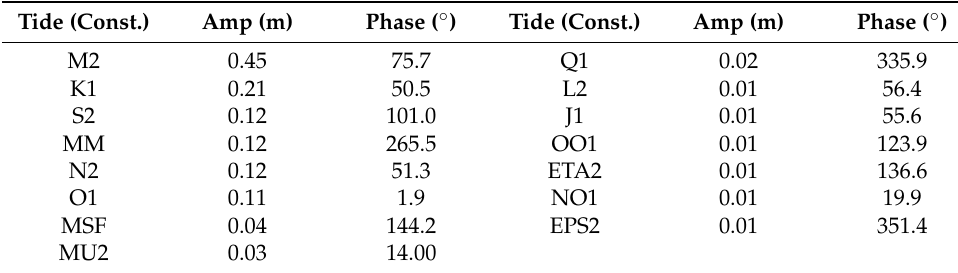
Table 4. Tidal constituent derived from Coronel’s tidal gauge.